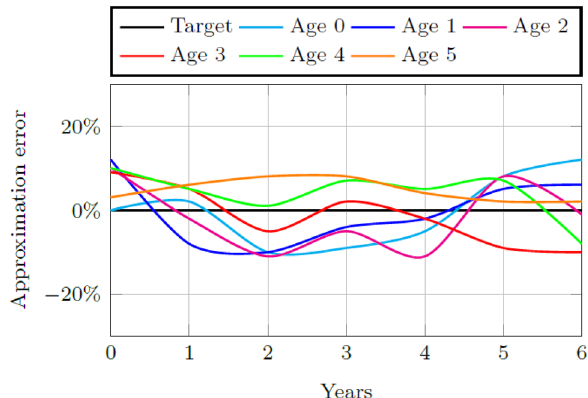
Fig. 4 Model approximation of reality for the calibrated weights for the number of ECD enrolled children per age group in Quintiles